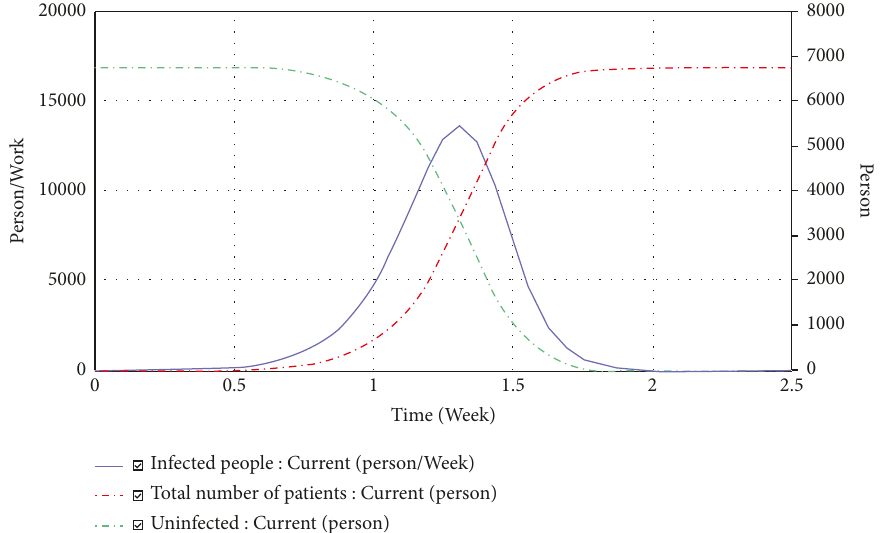
Figure 4: Simulation results of an infection evolving in the first